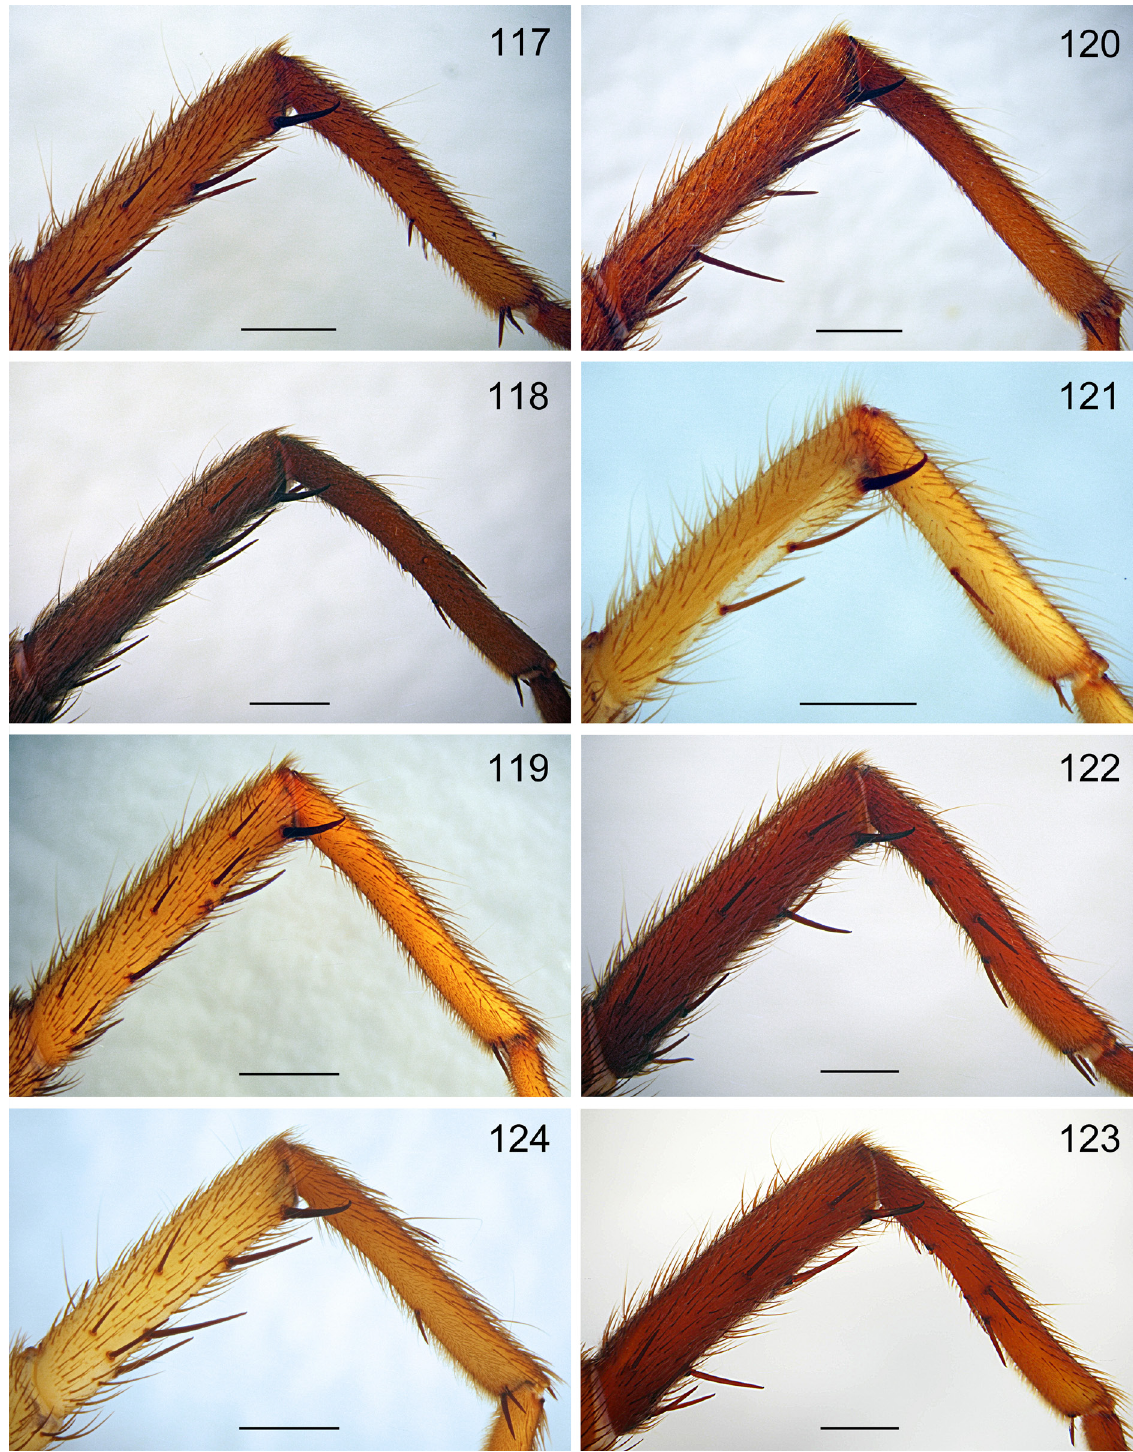
Figs 117–124. Anemesia spp., ♂♂, tibia and metatarsus I, retrolateral views. 117 . A. birulai (Spassky, 1937) (holotype). 118 . A. koponeni Marusik, Zamani & Mirshamsi, 2014 (holotype). 119 . A. pococki sp. nov. (holotype). 120 . A. tubifex (Pocock, 1889) (Kalaimor). 121 . A. andreevae sp. nov. (holotype). 122–123 . A. oxiana sp. nov. (holotype and paratype from Sanglok Mts, respectively). 124 . A. sogdiana sp. nov. (holotype). Scale bars: